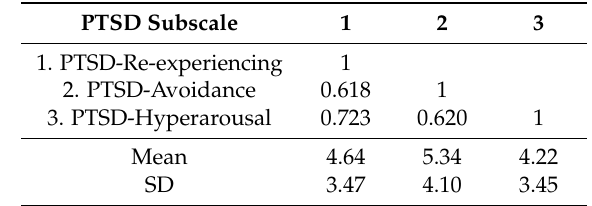
Table 3. Pearson correlation matrix of PTSD symptoms in children measured with the Child PTSD Symptom Scale (CPSS) [55]. PTSD Subscale